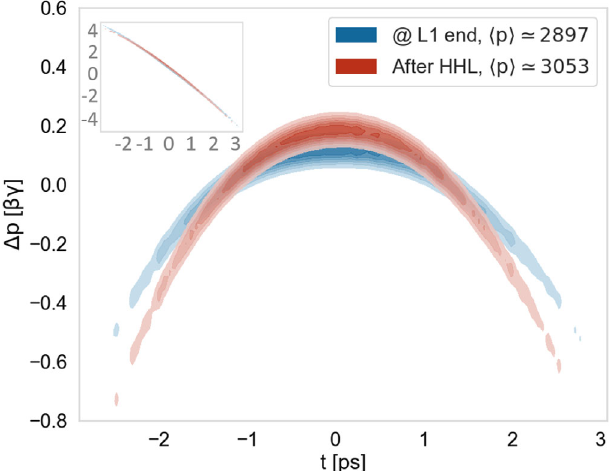
FIG. 6. LPSs comparison (kernel density evaluation) before and after passing through the HHL. On the left upper corner the chirped LPSs are shown, while, for sake of clarity, in the central image has been subtracted the linear correlation. The acquired curvature is well visible in the red distribution which is also, on average, 80 MeV more energetic.